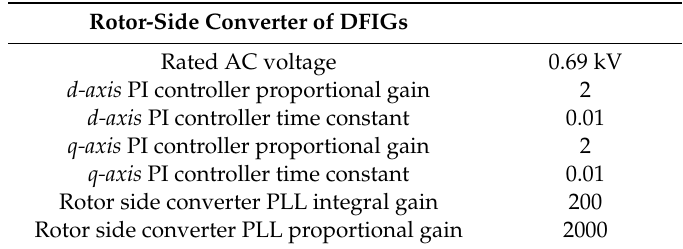
Table A3. Converter parameters and controller gains for rotor-side converter of